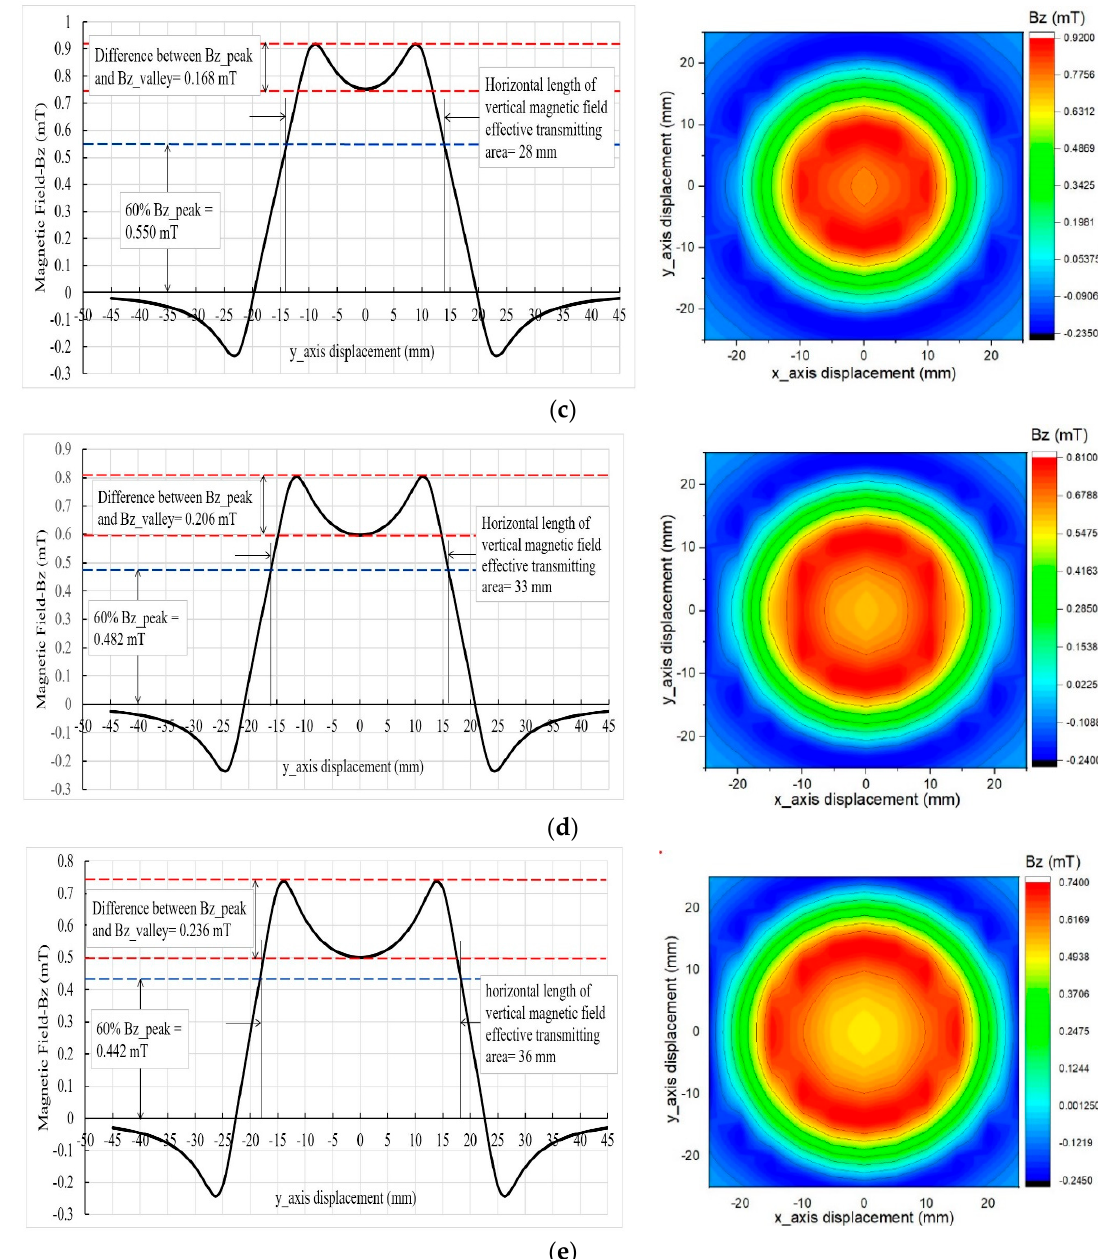
Figure 8. Vertical magnetic field distribution characteristic curve along the y-axis, and overall vertical magnetic field distribution with magnetic field effective transmitting area: ( a ) Coil with Di = 10 mm; ( b ) Coil with Di = 15 mm; ( c ) Coil with Di = 20 mm; ( d ) Coil with Di = 25 mm; ( e ) Coil with Di = 30 mm.